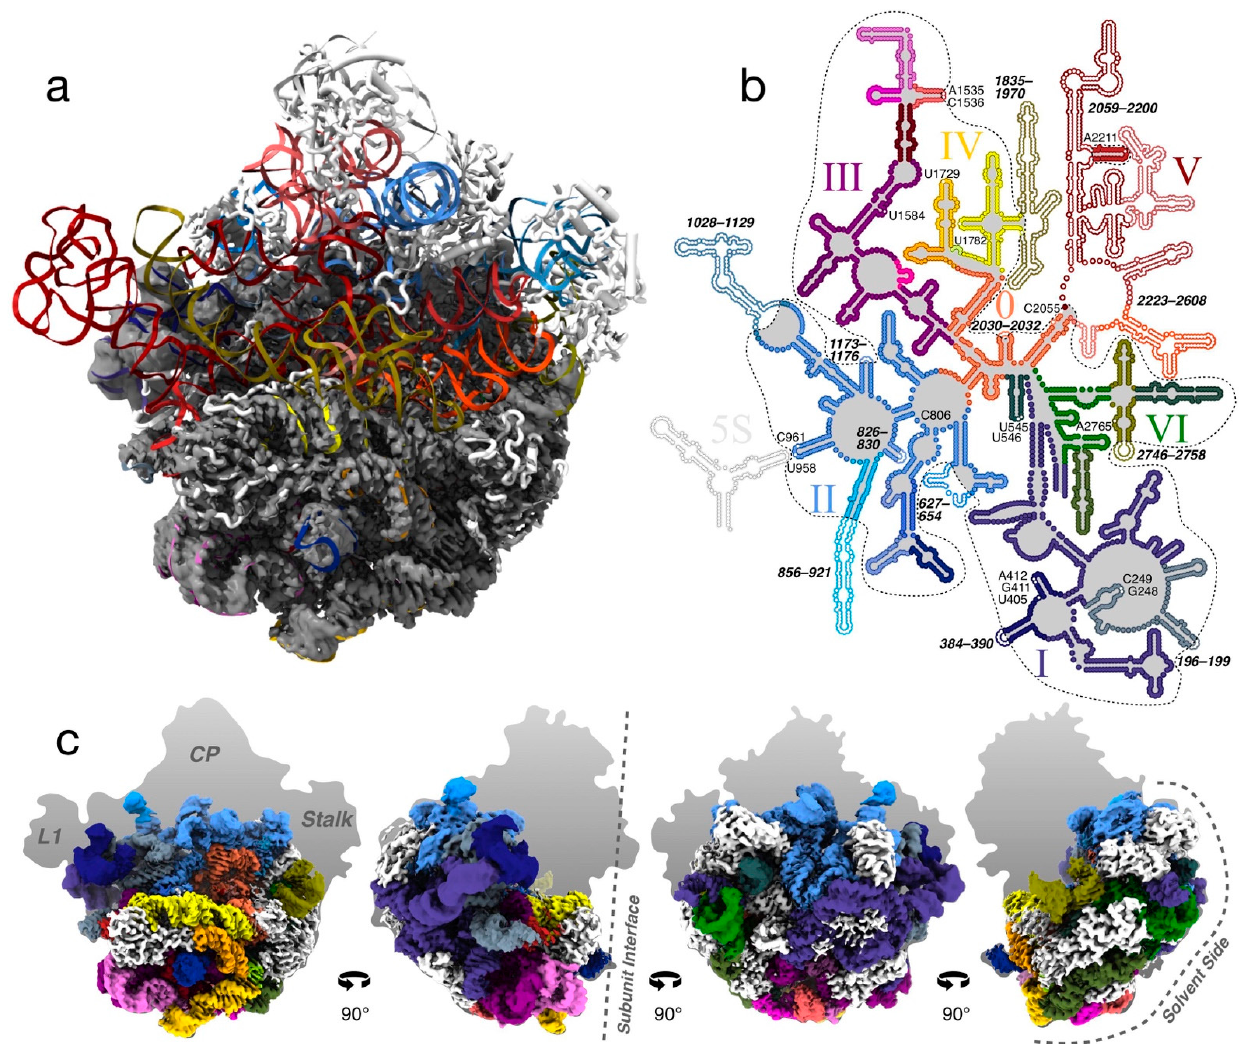
Figure 2. Consensus reconstruction of the 50S LiCl core particle. ( a ) The map (gray) in “crown view”, with a rigid-body docked model of the mature 50S particle (PDB ID 4YBB) colored as in ( b ). ( b ) Secondary-structure map of the LSU rRNA (adapted with permission (CC BY-SA 3.0) from Ref. [34]). Folded parts in the consensus particle are indicated with filled circles and outlined with a dashed line. Disordered helices, loops, or single nucleotides are shown as white dots and labeled. The RNA helices are colored in orange, indigo, blue, purple, yellow, or red tones for domains 0–VI, respectively. ( c ) Four different views of the map with the rRNA colored according to ( b ) and r-proteins in white.